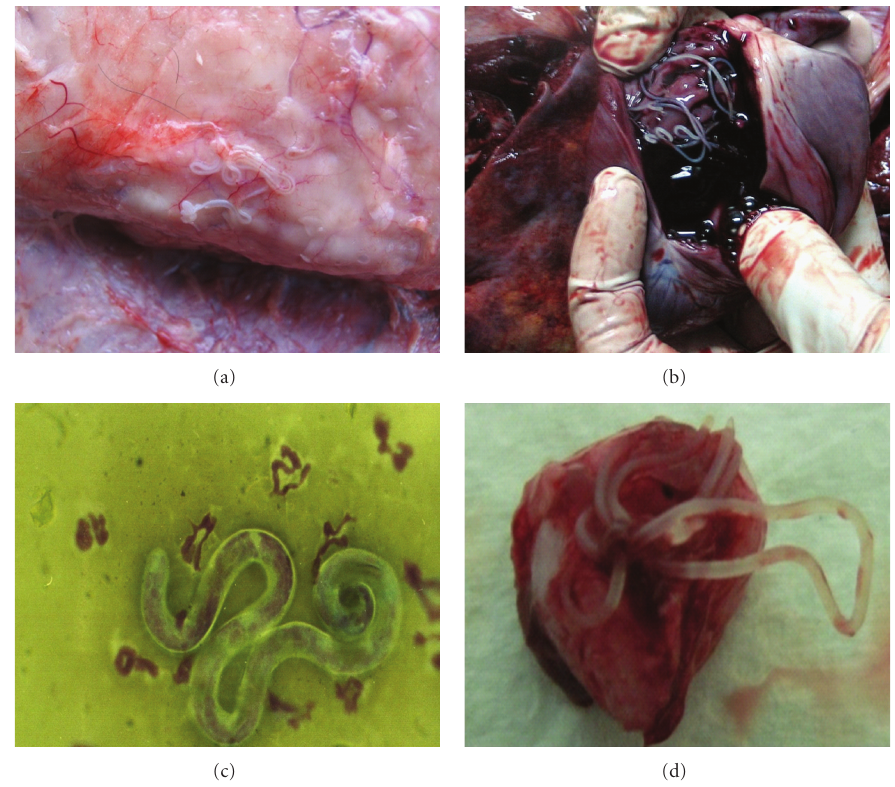
Figure 2: Representative images of the parasites observed in dogs and humans during the study. Canine subcutaneous dirofilariosis (a). Canine cardiopulmonary dirofilariosis (b). D. repens microfilariae from the blood of an infected dog (c). Human subcutaneous dirofilariosis. Excised nodule containing a D. repens adult worm